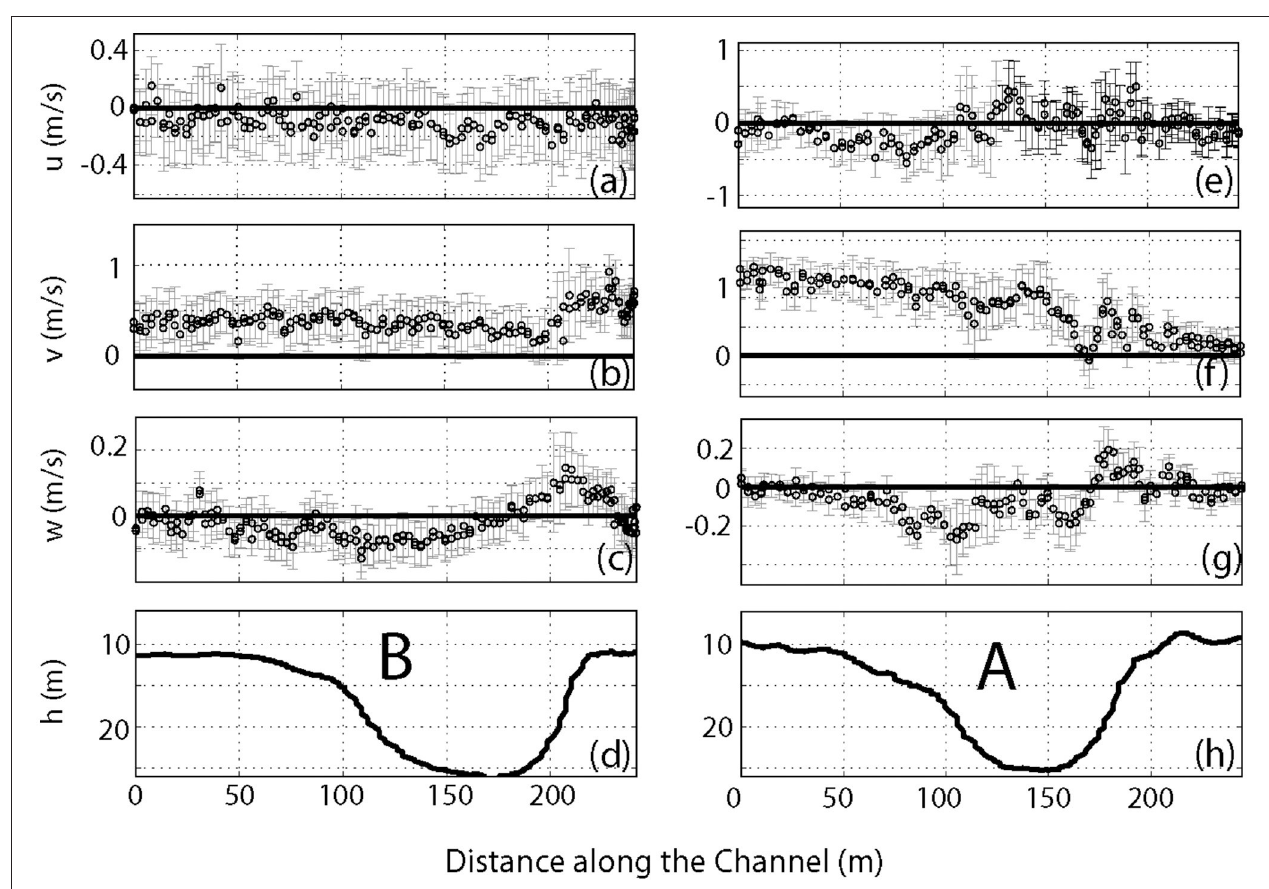
FIGURE 3 | Depth-averaged velocity for two of the first 6 transects, one over the northern scour hole. (A–D) Are the eastward, northward, and upward velocity components and water depth profile, respectively, for the second transects (No. 2 in Table 1 ). (E–H) Are the eastward, northward, and upward velocity components and water depth profile, respectively, for the third transects (No. 3 in Table 1